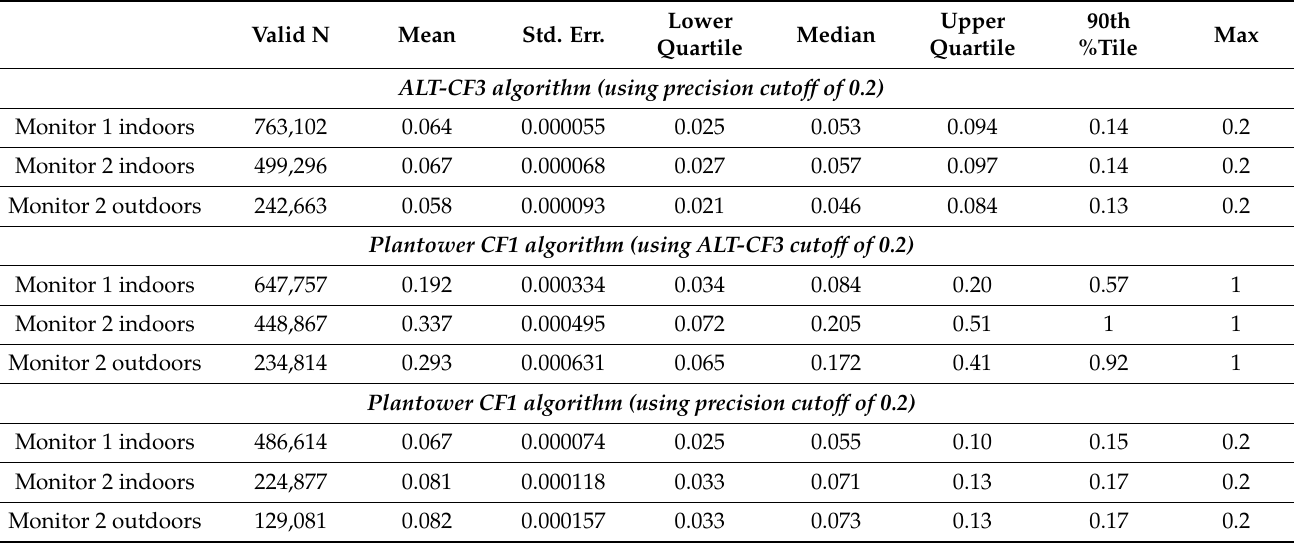
Table 1. Precision compared using ALT-CF3 and Plantower CF1 algorithms. Time period: 1 October 2019 to 14 January 2022.